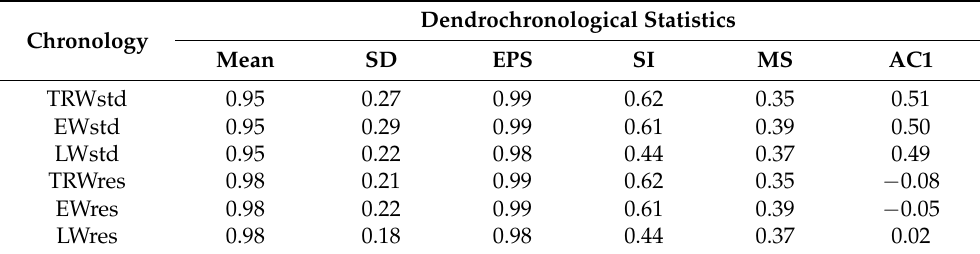
Table 1. Dendrochronological statistics for total ring width, earlywood, and latewood chronologies.